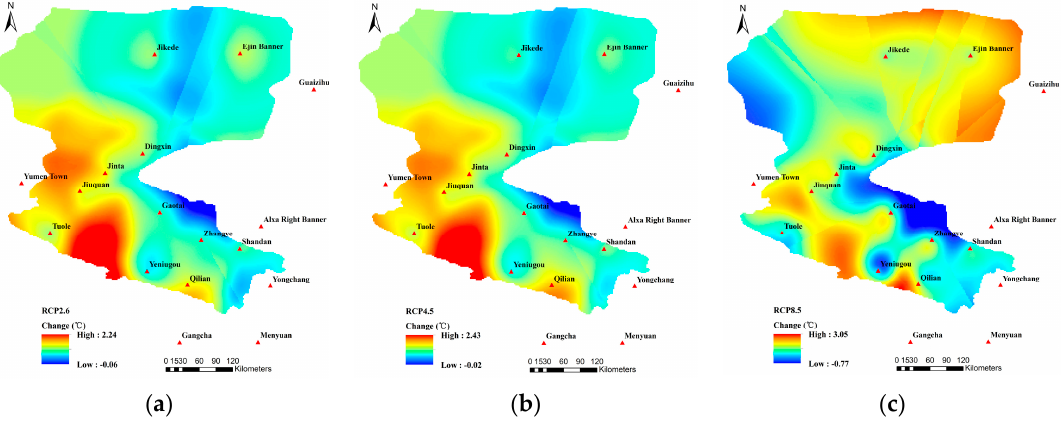
Figure 6. Spatial variation patterns of the T min under ( a ) RCP2.6; ( b ) RCP4.5; and ( c ) RCP8.5.